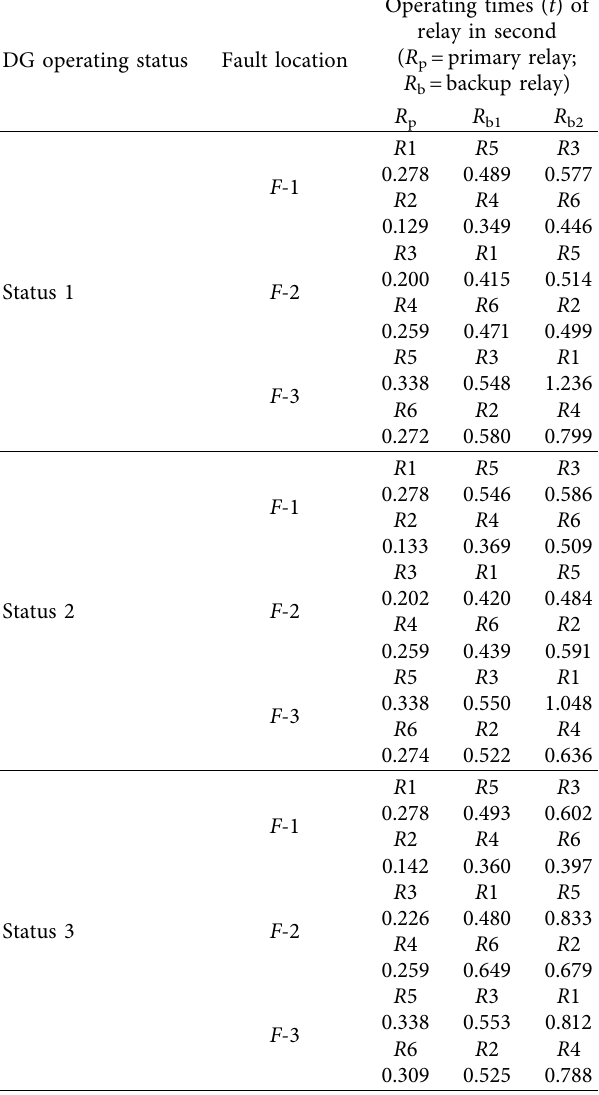
Table 7: Directional primary and backup relay operating times for conventional scheme in grid-connected microgrid.